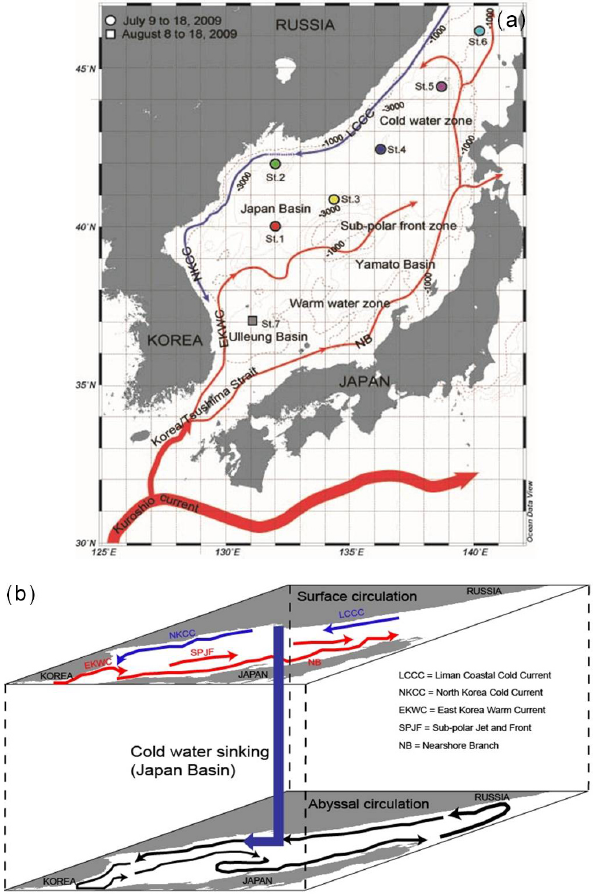
Figure 1. (a) A map of the region showing stations (St.) in the East/Japan Sea. (b) A schematic of the water circulations of the sur- face and bottom waters in the East/Japan Sea (Senjyu et al., 2005).